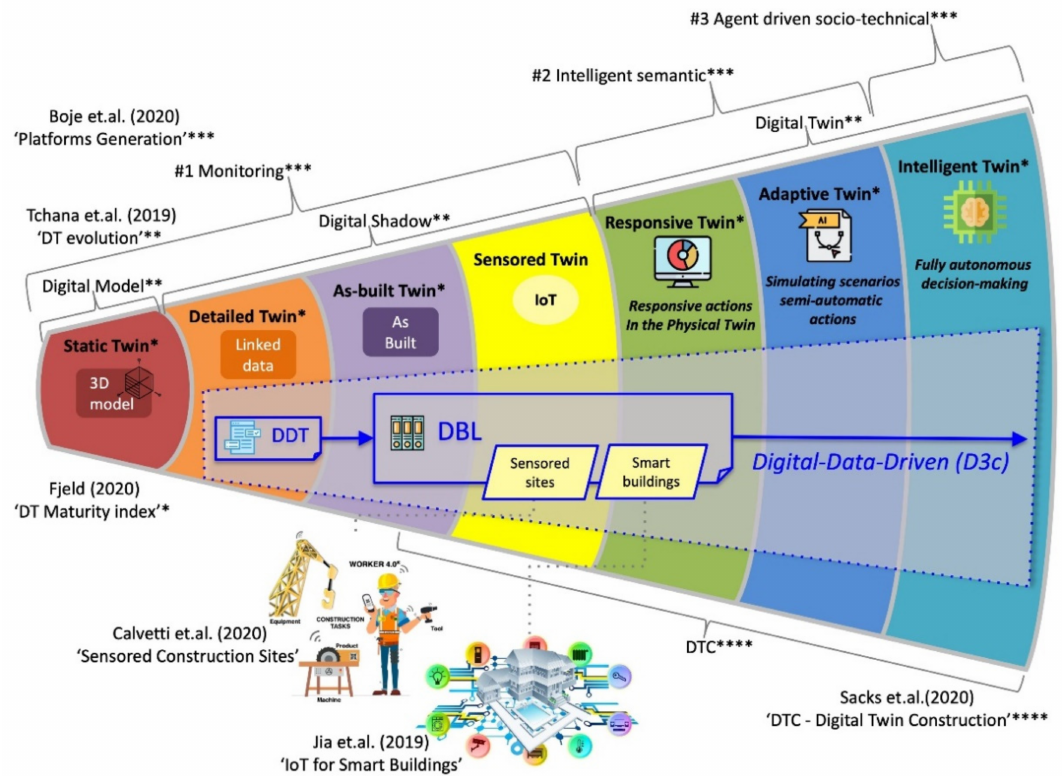
Figure 5. Digital twin construction incremental maturity levels (proposed conceptualisation V.1.0) The several (*) identify the different references; *—Fjeld (2020), **—Tchana et. al. (2019), ***—Boje et. al. (2020), ****—Sacks et. al.